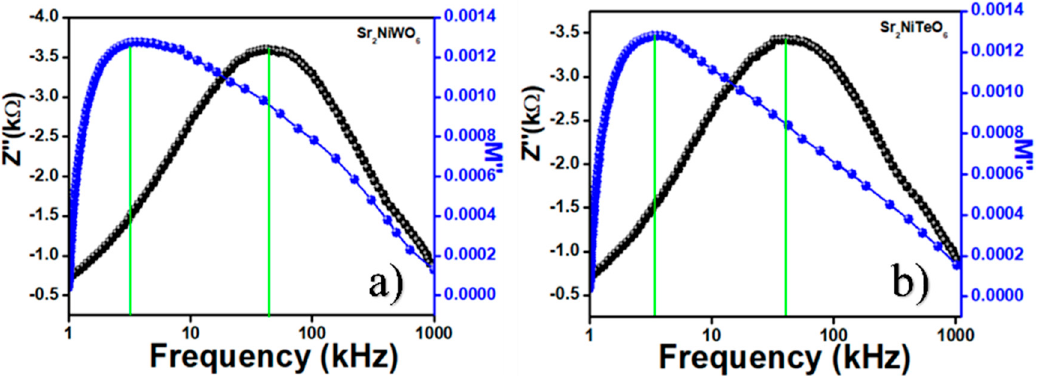
Figure 8. Frequency dependent imaginary part of impedance and modulus: ( a ) Sr 2 NiWO 6 and ( b ) Sr 2 NiTeO 6 ceramics.